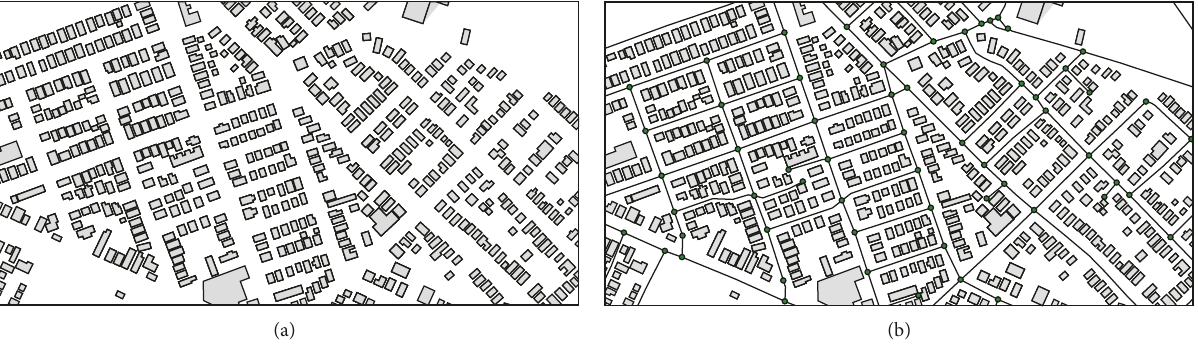
Figure 1: The single-layer network representation